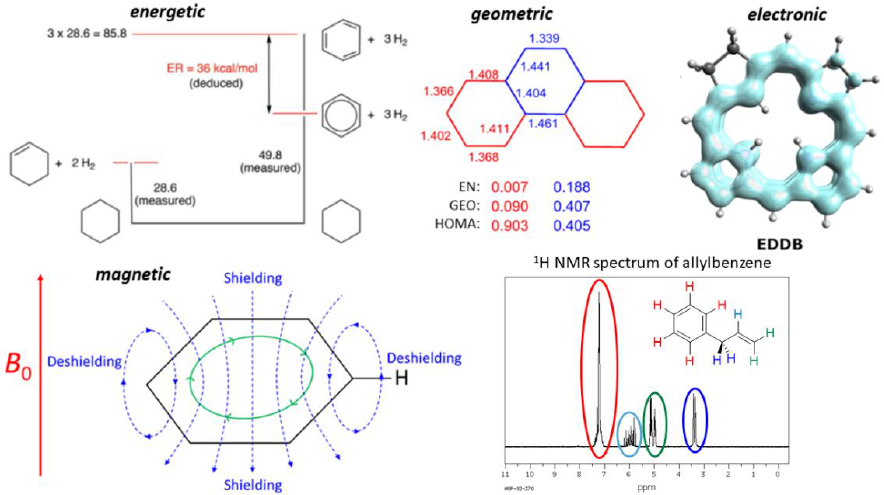
Figure 1. Energetic, geometric, electronic, and magnetic properties of molecules used for the assessment of aromaticity. The energetic scheme used in the evaluation of benzene resonance energy reprinted from Ref. [15], Copyright (2021), with permission from Elsevier. The NMR spectrum is taken from Ref. [16].